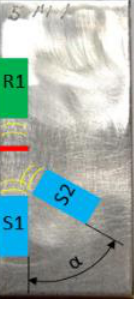
Figure 18. Measuring principle—sample with lateral defect.